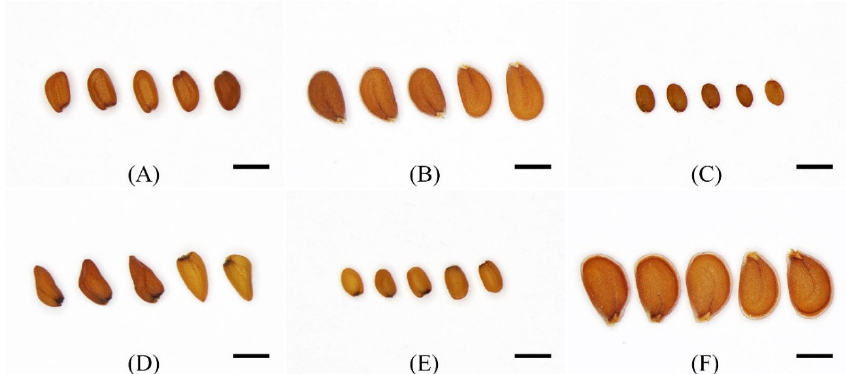
Figure 1. Stereomicroscope micrographs showing the seed morphology of six plant species. ( A